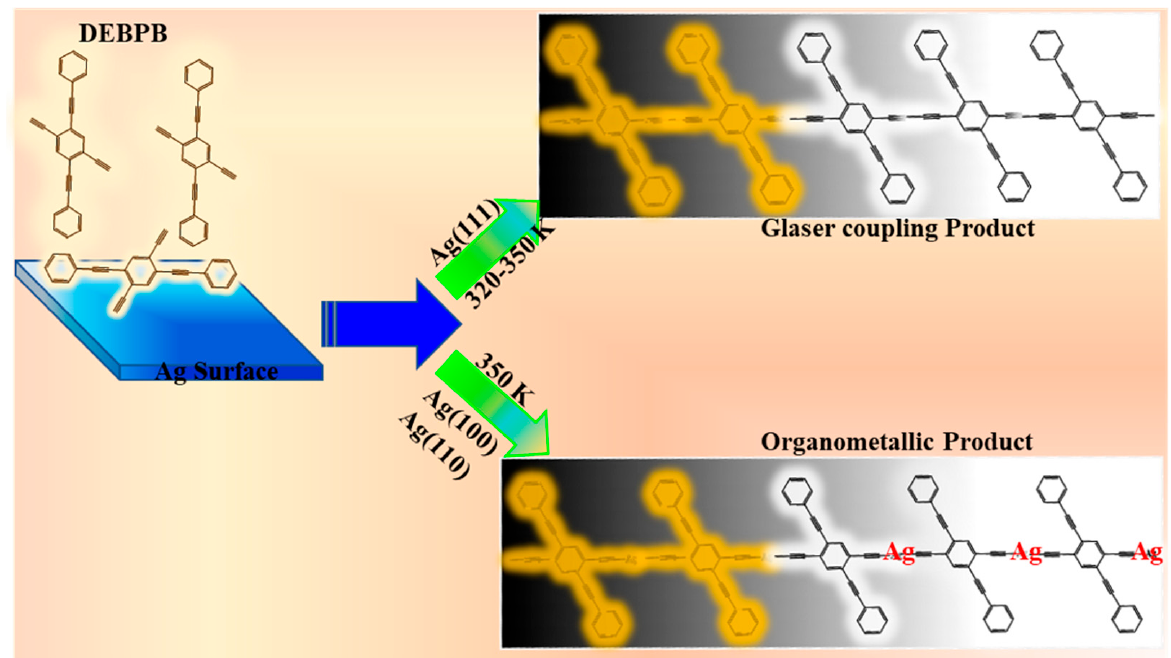
Figure 6. Schematic representation of the DEBPB coupling (Glaser reaction) carried out on silver surfaces. Redrawn [75].